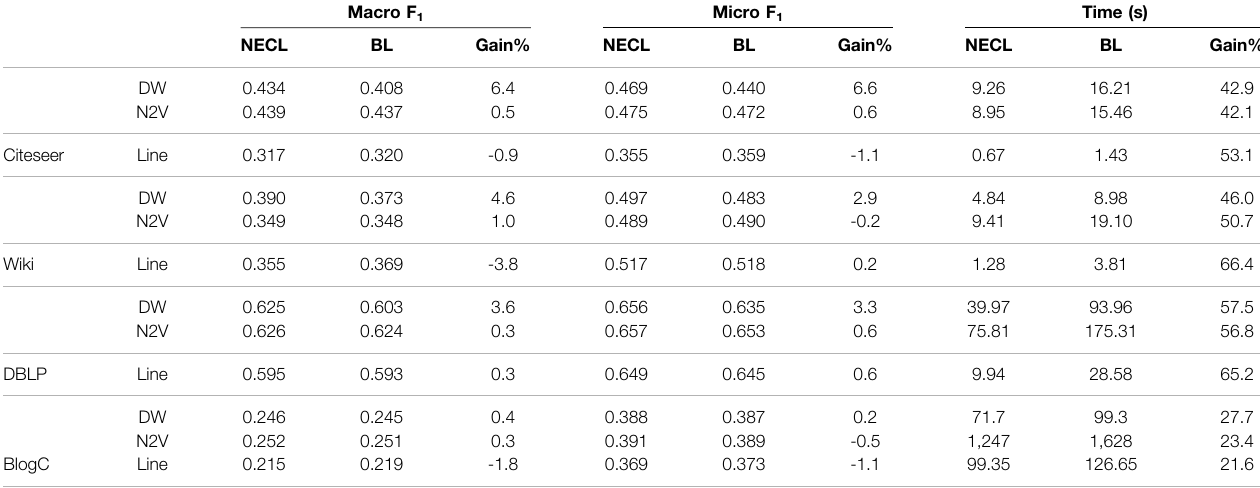
TABLE 1 | Performance comparisons of NECL with baseline methods (BL).